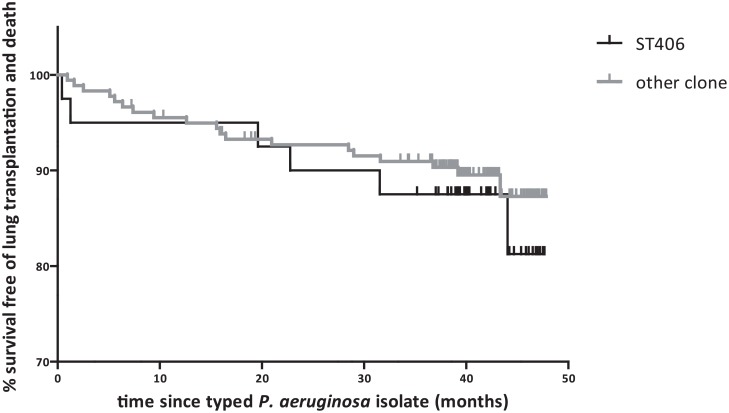
Survival free of lung transplantation or death.Survival free of lung transplantation or death for CF patients with ST406 and CF patients with other P. aeruginosa clones (total n = 219, lung transplantation n = 11, died n = 14).